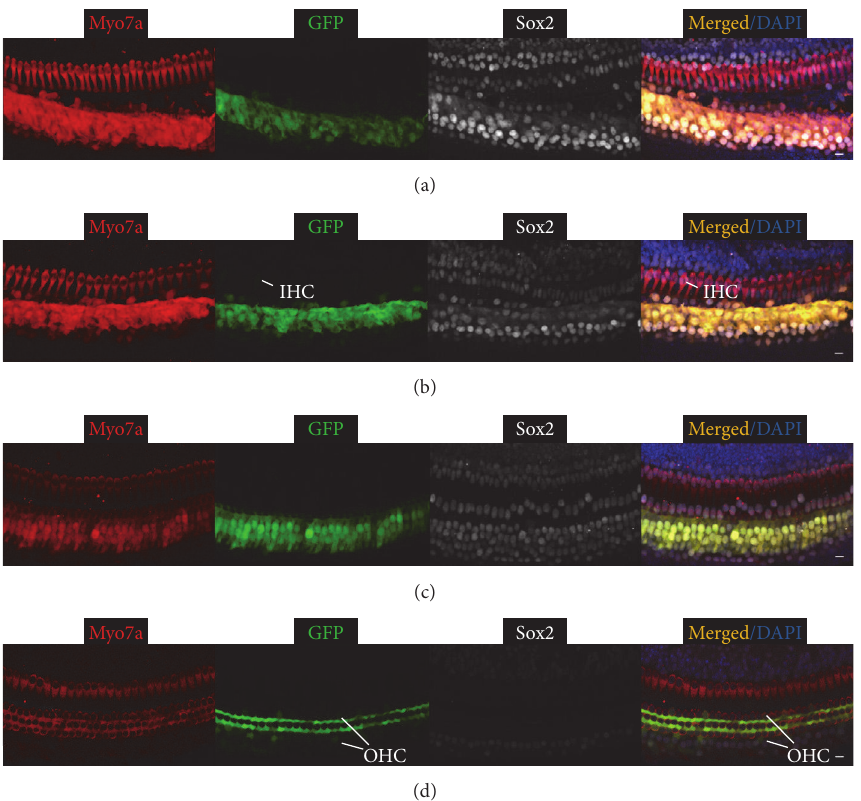
Figure 5: Ad-GFP-Baylor transduces mouse cochlea when injected at P4. Representative confocal images of whole-mount fluorescent immunolabeling P0 cochlea to illustrate the basal (a), middle (b), and apical turns (c, d). Ad-GFP-Baylor transduces SCs at basal (a), SCs and IHCs at middle (b), and SCs and OHCs at apical turns (c). Outer hair cells are transduced at the apical turn (d). IHC: inner hair cell; OHC: outer hair